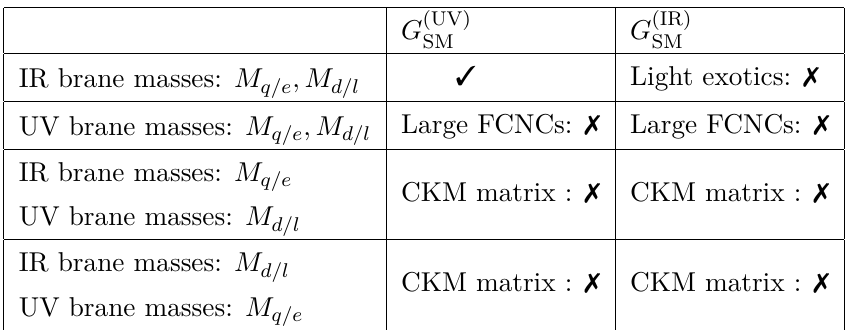
Table 1 . Summary of the different incarnations of SU(6) GHGUT. The mixed models fail to reproduce the CKM matrix while the UV-brane mass models suffer from large FCNCs. The IR- brane model with the SM on the UV brane is the most suitable as the IR variant suffers from light exotic